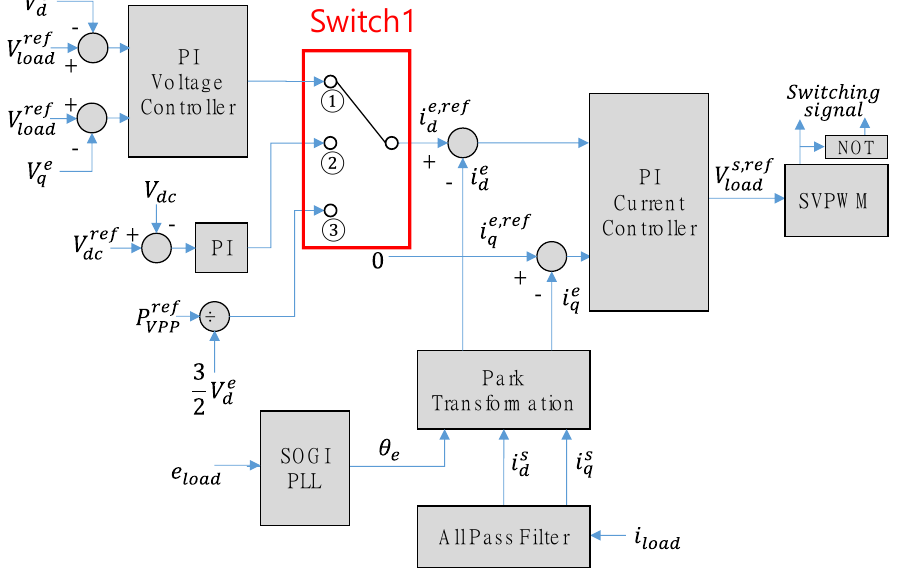
Figure 2. Control block diagram of the AC/DC interlinking converter (IC).